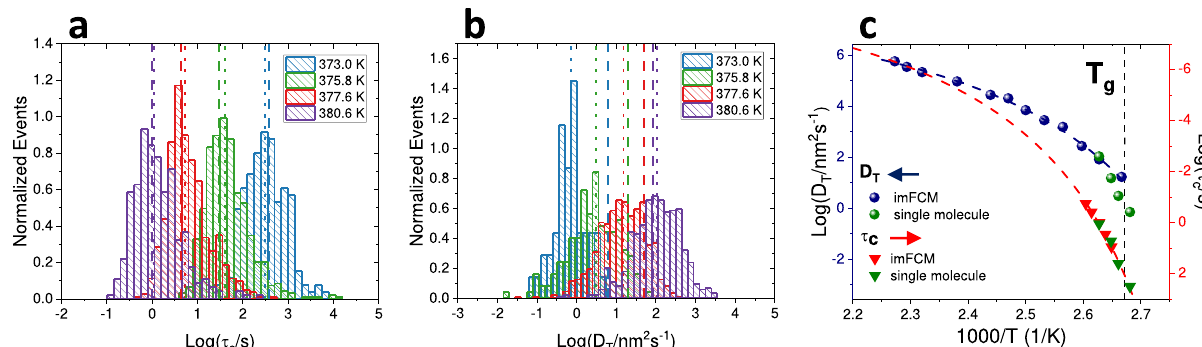
Fig. 1 Comparison of single molecule and ensemble results. a Single molecule rotational correlation time ( τ c ) distributions at four temperatures. Vertical dotted lines indicate median values and vertical dashed lines indicate τ c values obtained from ensemble imFCM at the same temperature or as extrapolated from a best fi t to the imFCM measurements (red dashed fi tted line in ( c )). In cases where a single vertical line is visible, the values are nearly identical. b Single molecule translational diffusion coef fi cient (D T ) distributions; vertical dotted lines indicate median values and vertical dashed lines indicate D T values at those temperatures or as extrapolated from a best fi t to the imFCM measurements (blue dashed line in ( c )). In ( a ) and ( b ) histograms are normalized by area under the curve. c Comparison of median single molecule results (green) to imFCM results in rotation and translation (red and navy, respectively). Navy dashed line is a polynomial fi t to the data. Red dashed line is a Vogel-Fulcher-Tammann [log ð τ = τ 0 Þ ¼ ð B ð T (cid:3) T with fi t values log( τ 0 ) = − 11.25, B = 414.15 K, and T 0 = 341.3 K, vertically shifted by 0.75. Rotational and translational results overlap at high temperature, where no breakdown is expected, and the widening gap between rotation and translation as T g is approached from above indicates rotational – translational decoupling, with more apparent decoupling in imFCM compared to in median single molecule results. T g , as indicated by a black dashed line, is determined by differential scanning